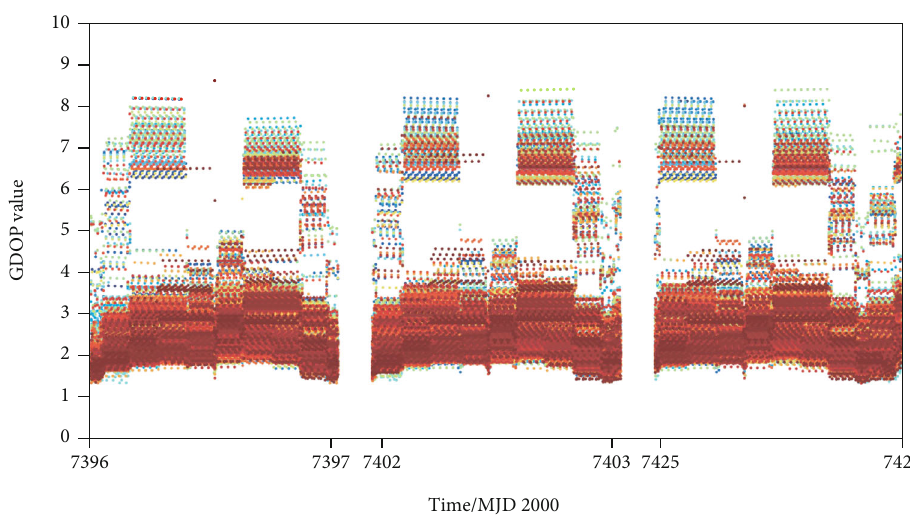
Figure 11: Navigation performance of the 70-satellite Flower